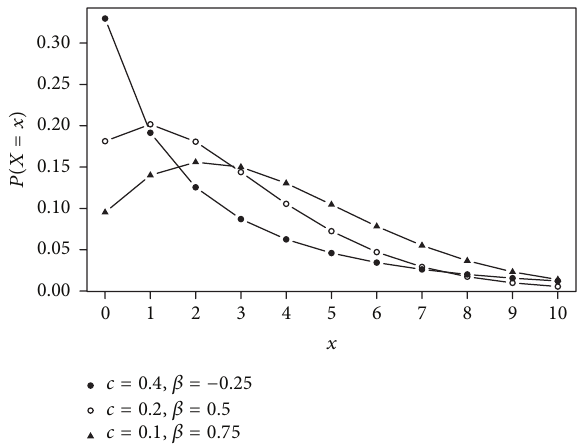
Figure 1: Probability mass function of type III discrete Weibull distribution for three combinations of